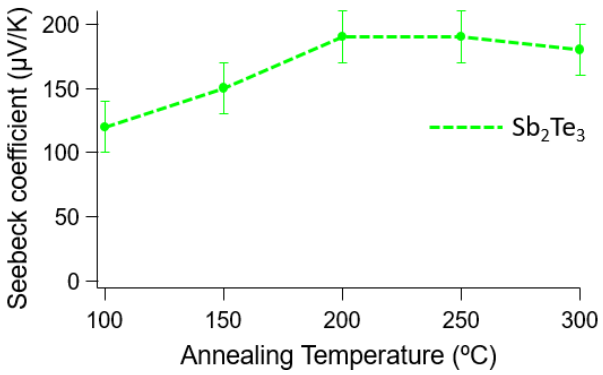
Figure 21. Dependence of the Seebeck coefficients from the Sb 2 Te 3 on the annealing temperature. Table 2. The effects of annealing on the Sb 2 Te 3 properties.